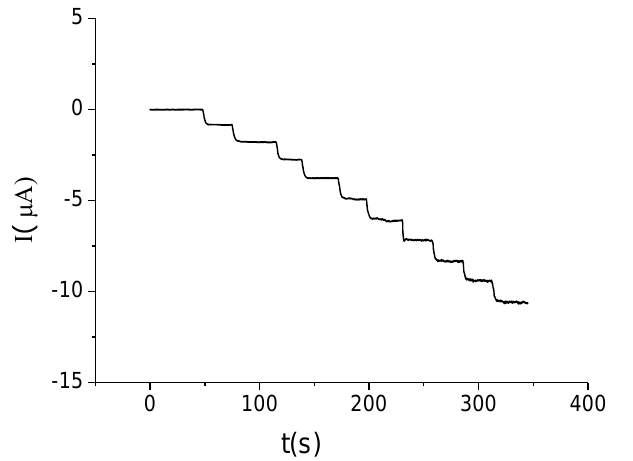
Figure 9. Typical steady-state current responses of the Hb/FDU-15 electrode on successive addition of 10 μM H O . Applied potential: –0.3 2 2